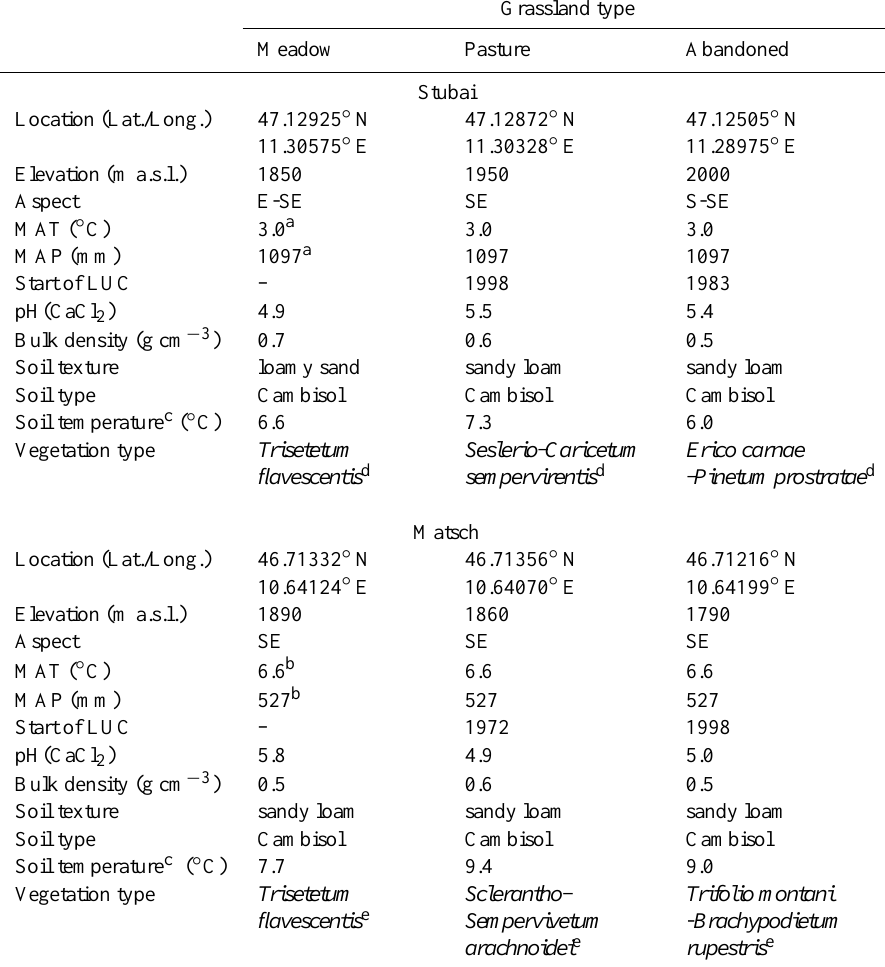
Table 1. Site and soil characteristics of upper 10cm of meadow, pasture and abandoned grassland at the Stubai and Matsch site. Grassland type Meadow